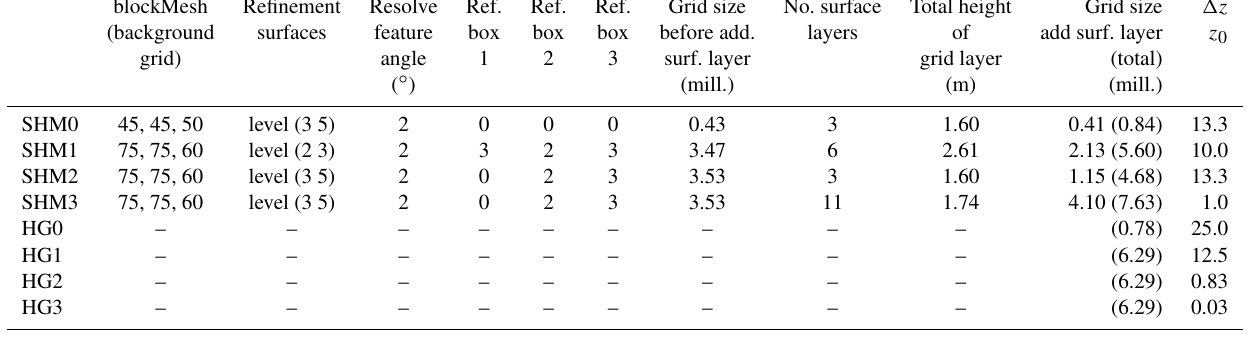
Table 5. Bolund Hill: overview of different control parameters used to generate the SnappyHexMesh-created grids. For the definition of different parameters in the table, see Table 2. Positions of refinement boxes, surface layers and background grid are indicated in Fig. 8. SHM0–3 are the SnappyHexMesh-based grids and HG0–3 are the HypGrid-based ones. z 0( L ) = z 0 − Land = 0.015m.